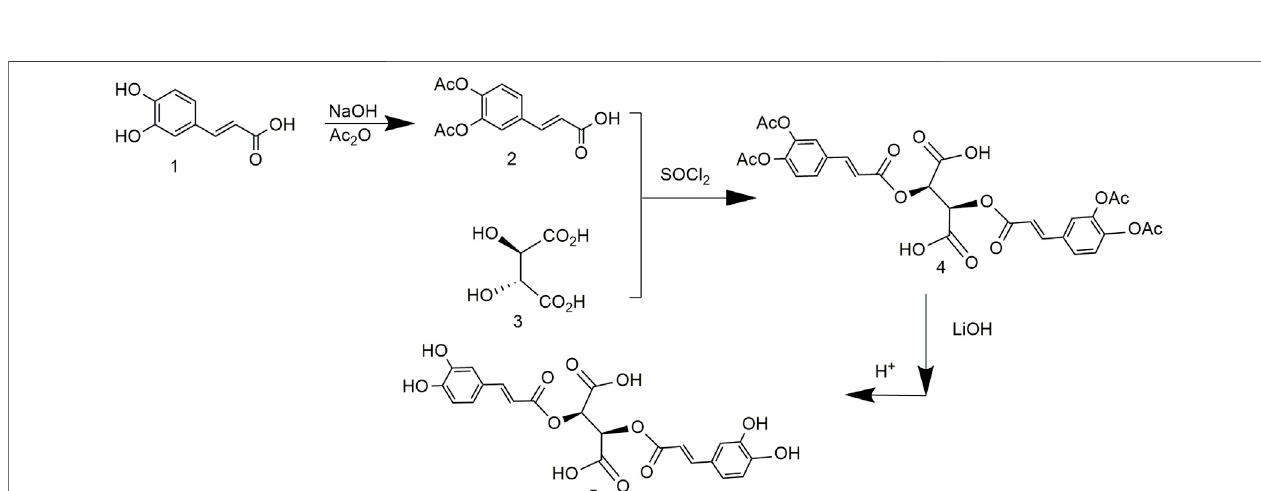
FIGURE 7 | Chemical synthesis pathway 5 of chicoric